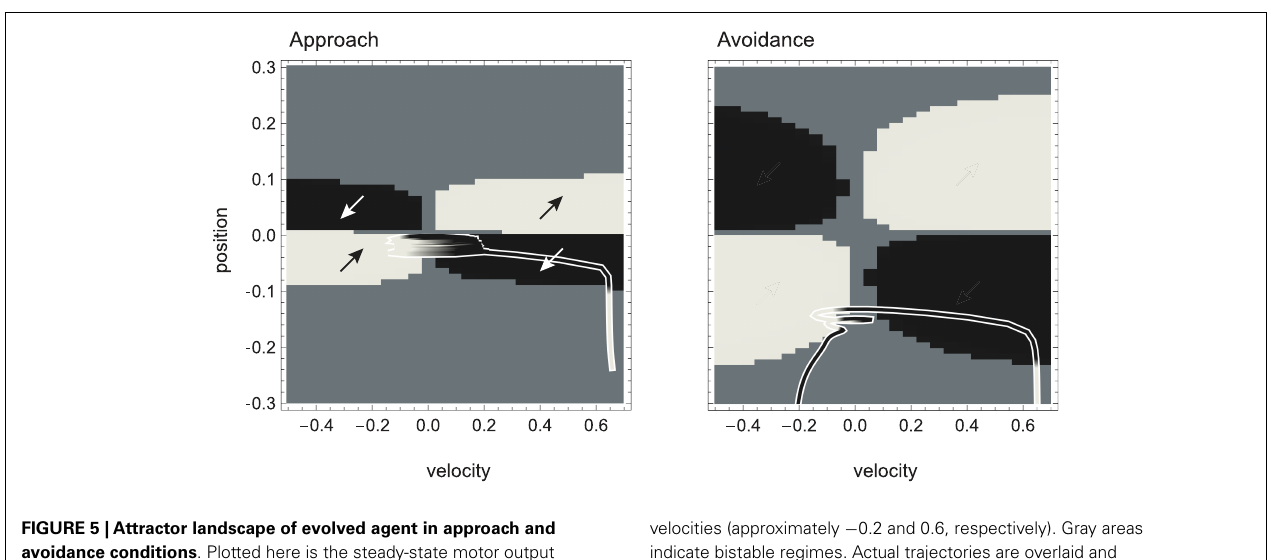
FIGURE 5 |Attractor landscape of evolved agent in approach and avoidance conditions . Plotted here is the steady-state motor output as a function of fixed sensory input resulting from a given motor command (velocity) at a given position. Black attractor regions correspond to negative and white regions to positive steady-state